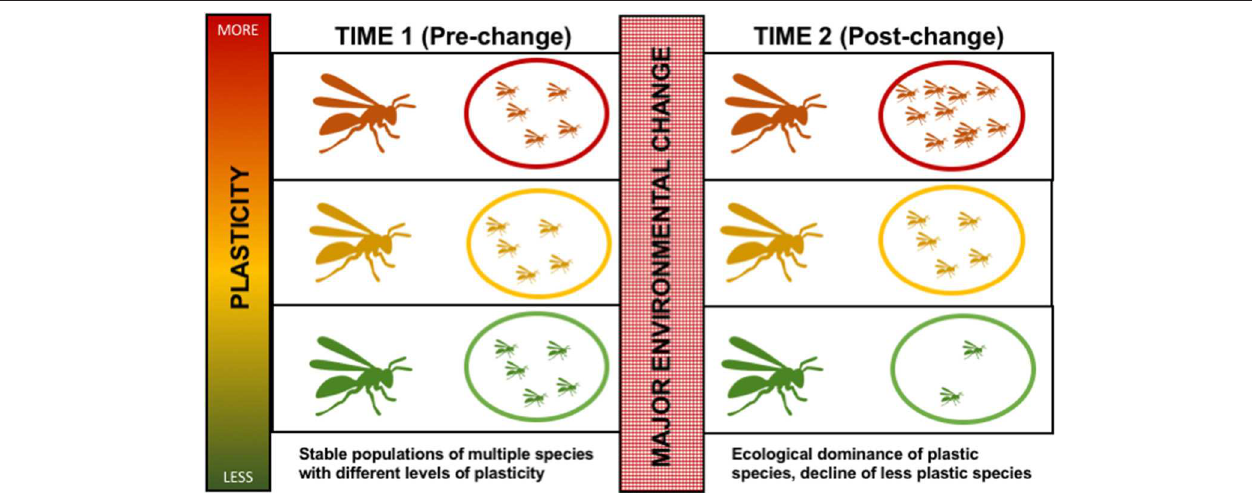
FIGURE 1 | Schematic representing how phenotypic plasticity may contribute to species declines or species invasions in the face of a major environmental change. Three hypothetical species are represented with variation in their level of phenotypic plasticity (overall plasticity, or related to specific traits) (see text). These hypothetical species vary in their level of phenotypic plasticity at both individual (insect drawing) and colony (nest drawing) levels, with green representing lowest plasticity, rust representing highest plasticity, and yellow representing intermediate plasticity. At time 1, all three species are able to coexist with stable populations (ovals), each taking advantage of different ecological niches with the less plastic species being successful despite lacking plasticity due to being able to specialize on certain aspects of its environment. A major environmental change (red stippled box in center) occurs, such as major habitat loss, climatic shift, arrival in a new exotic region, or stress from disease, toxins, or new competitors. At time 2, the major environmental change has served as a filter, with a higher probability of more plastic species (rust) prospering and increasing their populations (rust oval) with this change due to their ability to rapidly adapt to change and/or enter new niches. At the same time, the less plastic and more specialized species (green) is less likely to fit this new environment or withstand a large change and experiences population declines (green